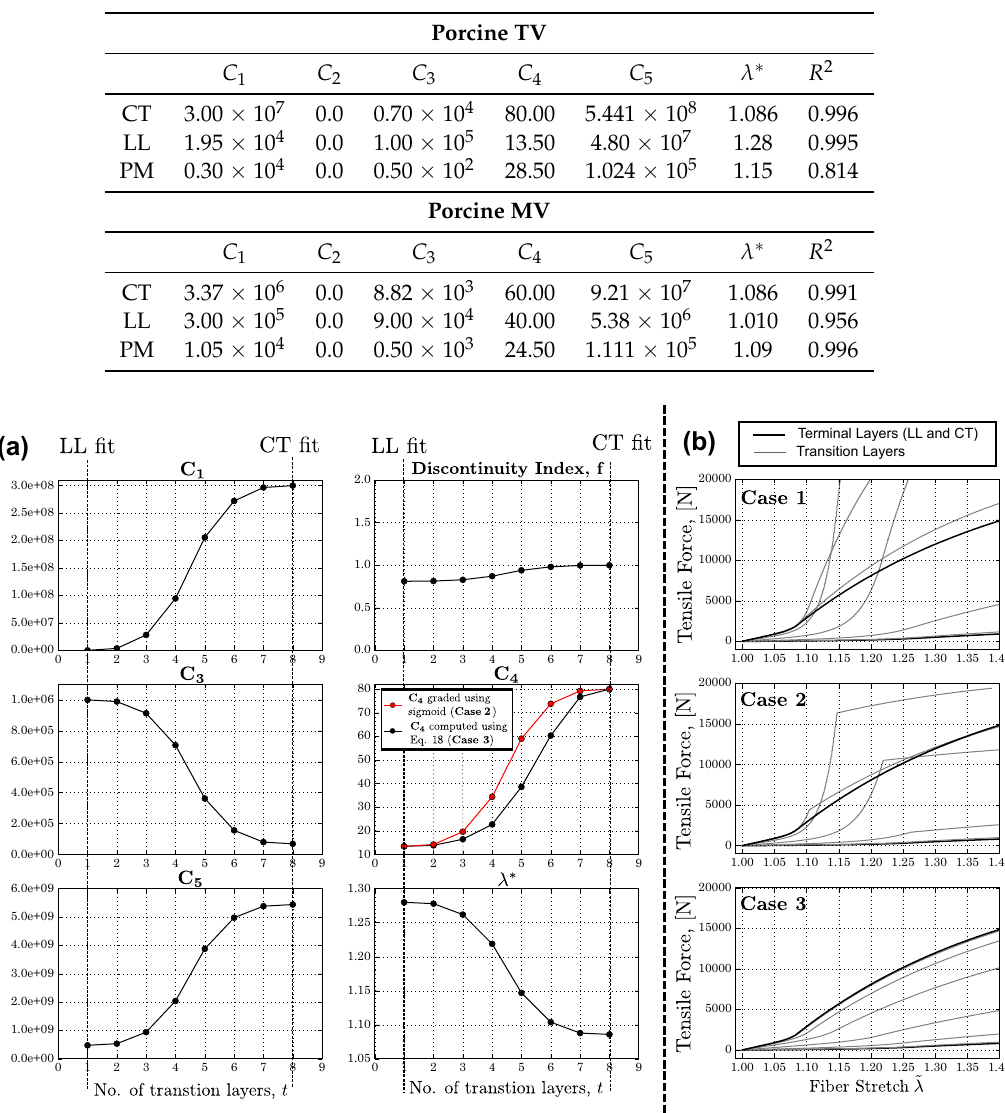
Table 1. Fitted TI parameters in porcine tricuspid valve (TV) and mitral valve (MV). Units of C 1 – C 3 and C 5 in Pa. C 4 and λ ∗ are dimensionless. A bulk modulus of K = 1.464 × 10 8 Pa was assumed [39].